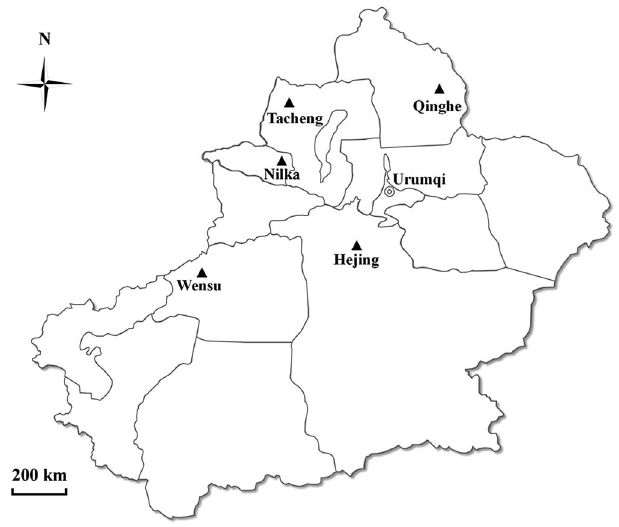
Figure 1. Speci fi c locations from which samples were collected in this study. N Study